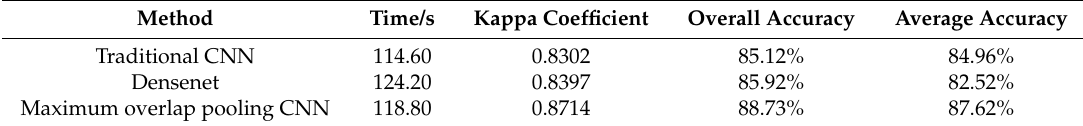
Table 5. Convergence time and accuracy of different classification methods used Indian Pines dataset.